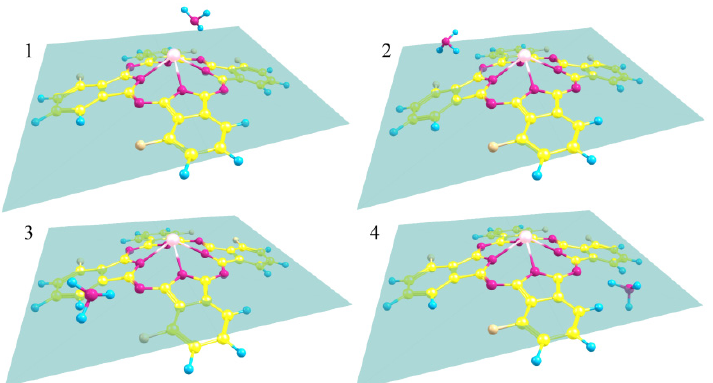
Figure 10. Structure of PbPcF 4 -np/NH 3 aggregates. The indicated plane passes through bridge ni- trogen atoms to show the position of the NH 3 molecule relative phthalocyanine surface, numbers 1- 4 indicate type of